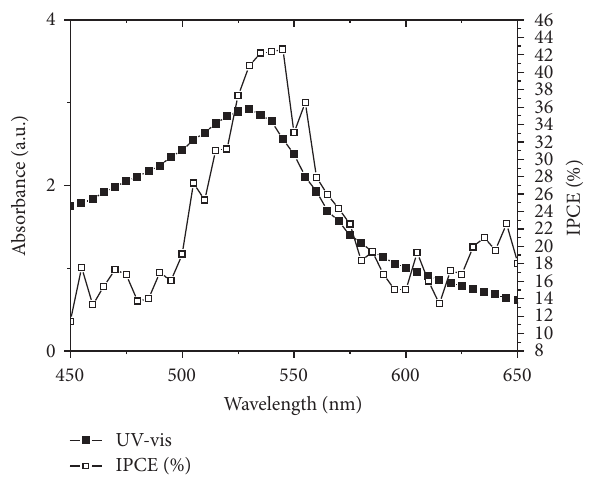
F 1: IPCE spectra of the DSSCs and UV-vis of N719 dye.